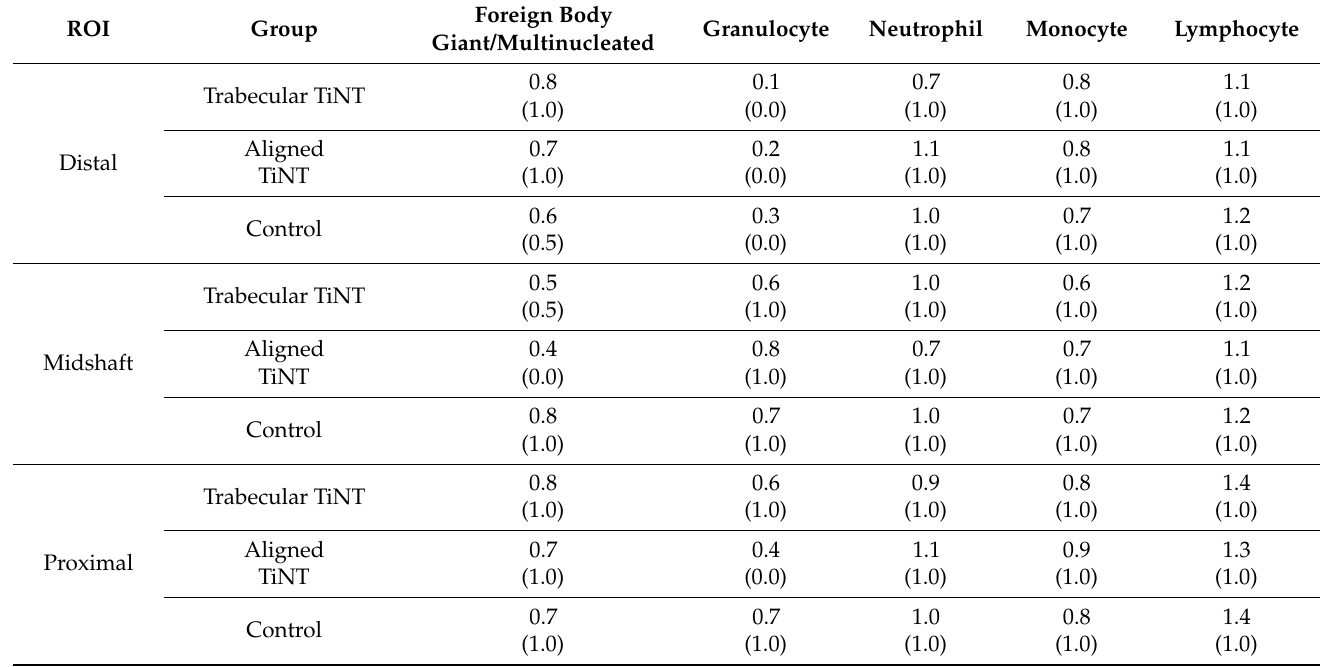
Table A1. Average histologic grade for three regions of interest in each treatment group *.